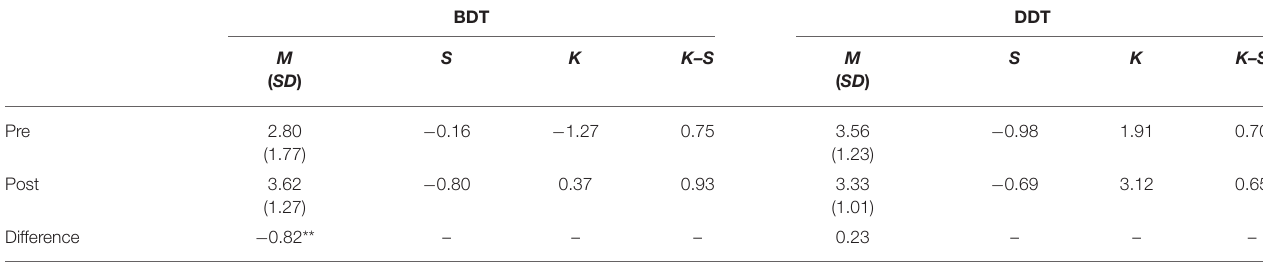
TABLE 4 | Discrimination sensitivity ( d ′ ) in BDT and DDT before and after the mindfulness training in the national team ( n = 41).